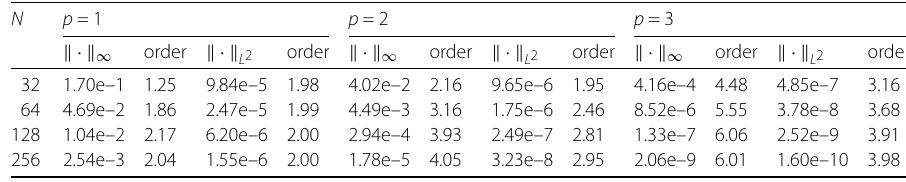
Figure 3 Convergence curve, Shishkin mesh, τ (cid:2) = min { 0.5,– (cid:2) ( p + 1)ln (cid:2) } , p = 1